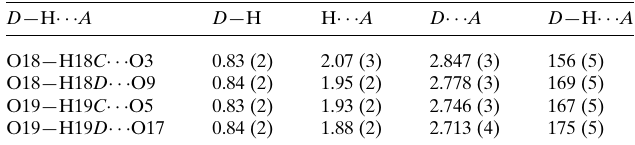
Table 4 Hydrogen-bond geometry (A˚ , (cid:4) ).